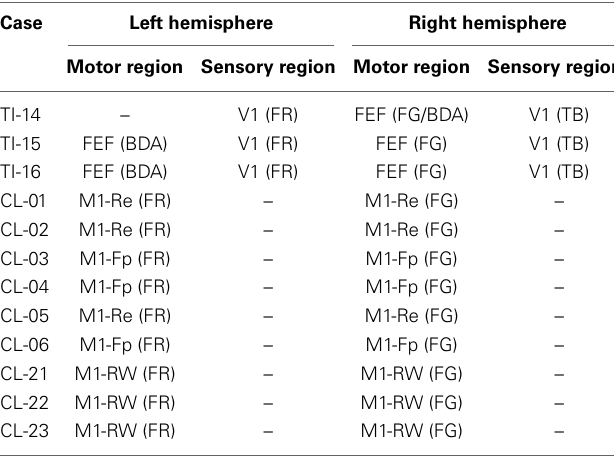
Table 1 | Summary of tracer injections from current study and previously published data (Smith and Alloway,